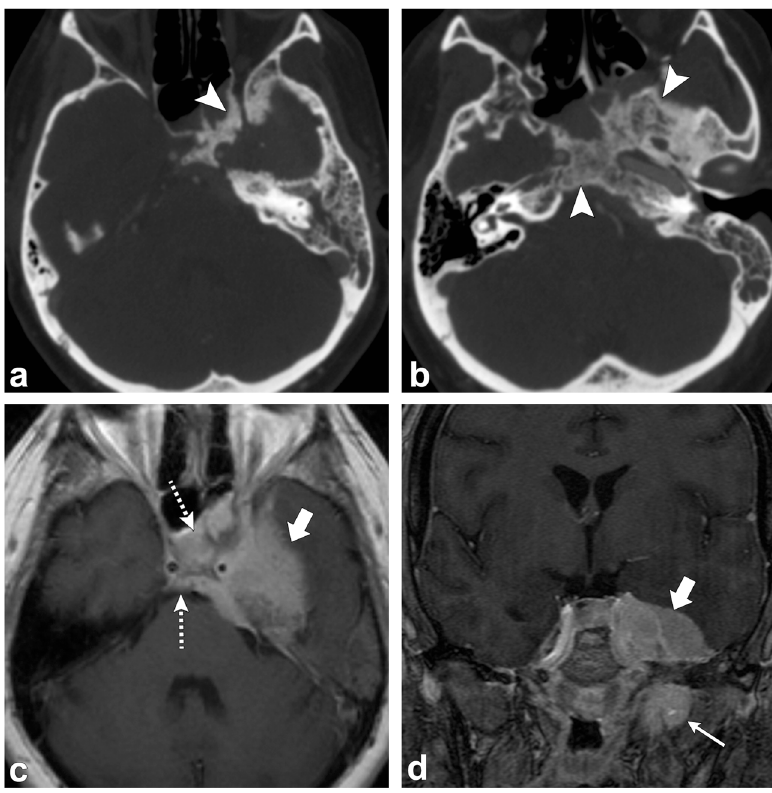
Fig. 8 Intradural meningioma. Axialhead CTimages ( a , b ) show hyperostosis of the left sphenoid bone, clivus and petrous portion of the left temporal bone ( arrowheads ). Axial ( c ) and coronal ( d ) post-contrast T1- weighted images show a large enhancing lesion along the left sphenoid wing ( thick arrows ) extending along the clivus and sella ( dashed arrows ), as well as left middle cranial fossa ( short, thick arrow ); there is also extension outside of the calvarium ( thin arrow )